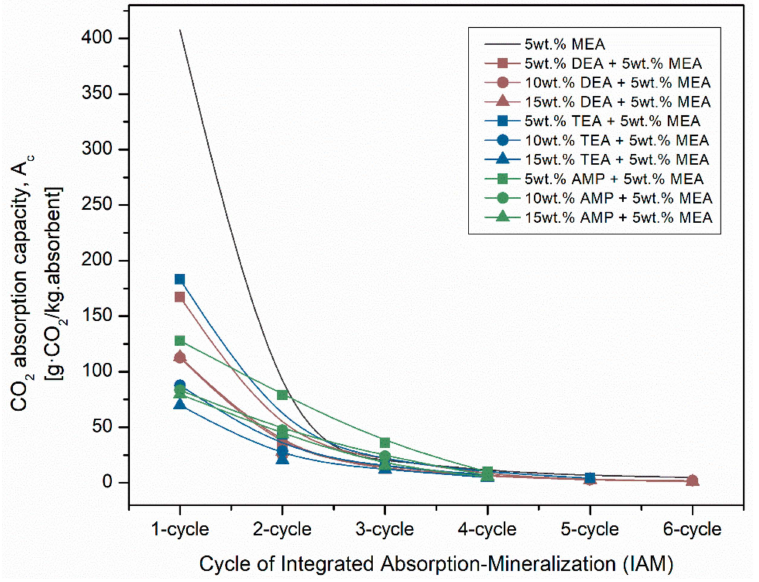
Figure 4. CO 2 absorption capacity of blended alkanolamine absorbents in multicycle integrated absorption–mineralization